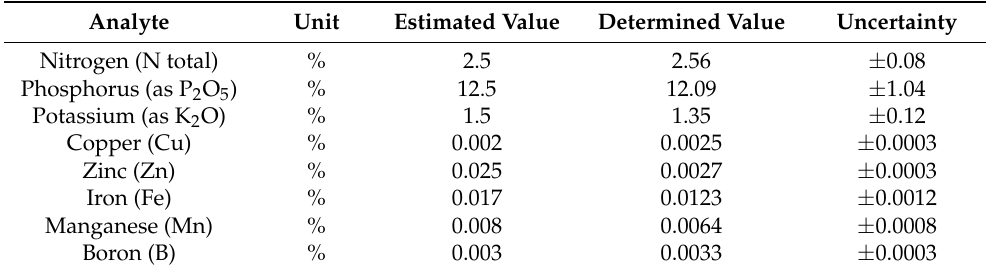
Table 2. Composition of the prepared foliar fertilizer F1, estimated value (according to receipt) and determined value.